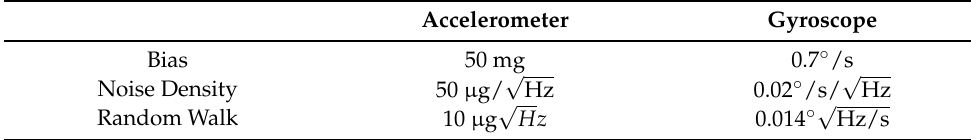
Table 3. Properties of the IMU used in the